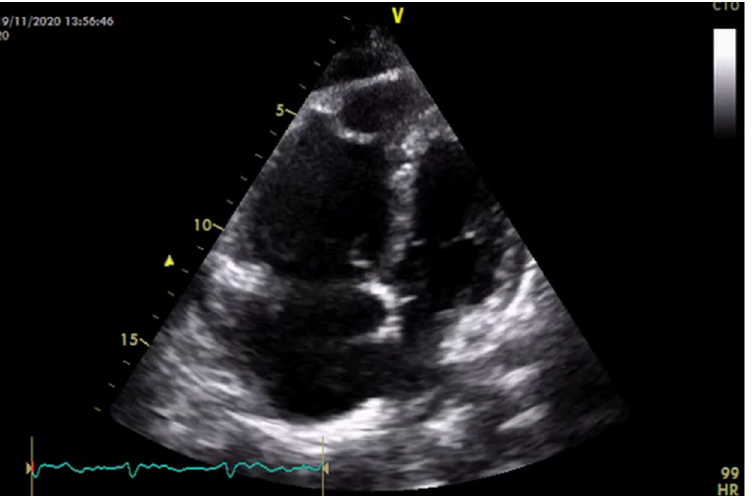
Figure 6. A 4-chamber view of standard echocardiography in a patient with PH. As results of the increased afterload, RV wall hypertrophies and dilates, developing a spherical shape accompanied by increased RV wall stress, RV dysfunction and severe RA dilatation.